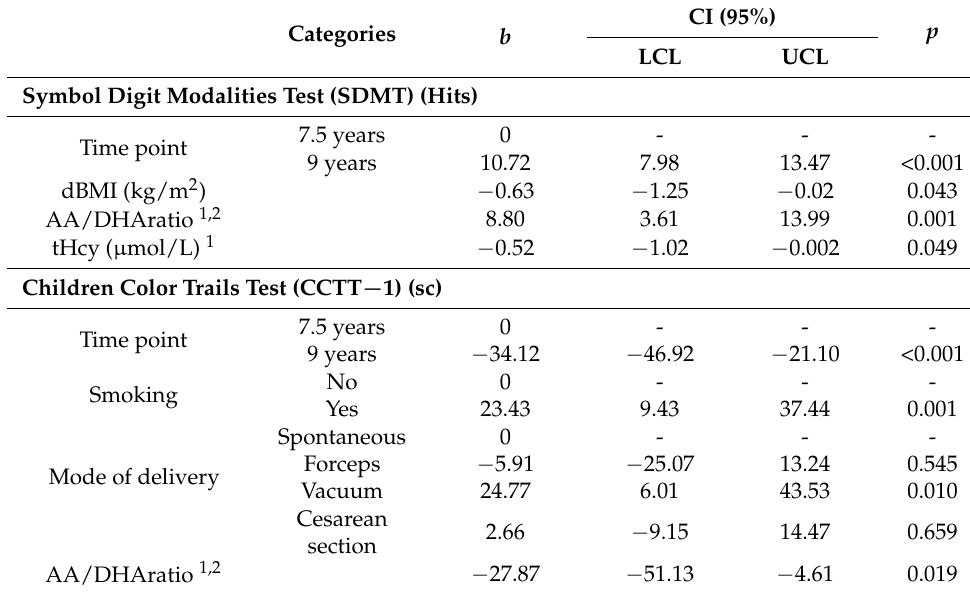
Table 3. Effect of selected cofounders on the processing speed outcomes in the NUHEAL children. Only significant associations are